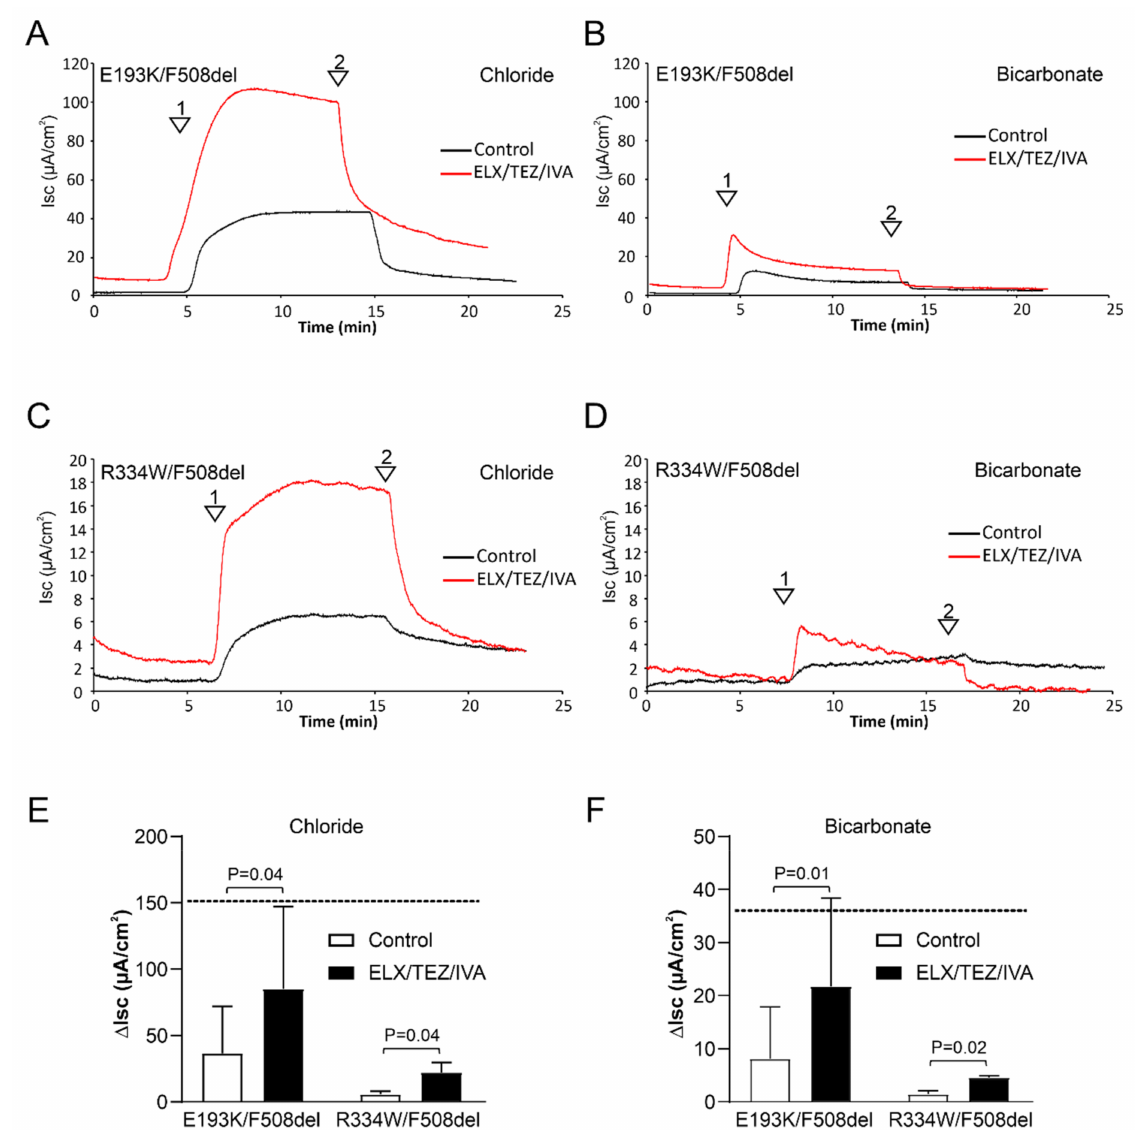
Figure 3. Stimulation of CFTR-mediated chloride and bicarbonate transport by ELX/TEZ/IVA in epithelial monolayers (2D HIOs). ( A – D ) Representative Isc recordings of the effect of CFTR modulators on forskolin-induced Isc responses. ( A , B ) Patient 1 (E193K/F508del). ( C , D ) Patient 2 (R334W/F508del). Experiments were performed in medium that either contained chloride ( A , C ) or bicarbonate ( B , D ) as the single CFTR-permeating anion. Arrowheads indicate the addition of forskolin (1) and CFTRinh172 (2), respectively. ( E ) Aggregate data showing peak Isc responses elicited in chloride medium. ( F ) Aggregate data showing peak Isc responses elicited in bicarbonate medium. The horizontal, dotted line denotes the magnitude of the forskolin-induced Isc response in organoid monolayers expressing wildtype CFTR. Mean ± SD of 6 (E193K/F508del) or 3 (R334W/F508del) technical replicates are